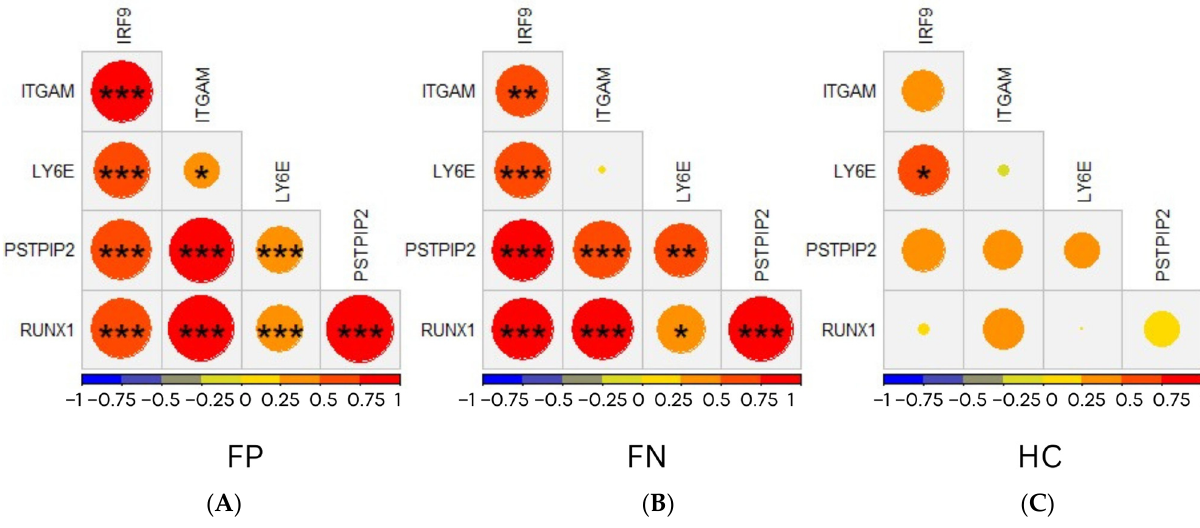
Figure 3. Correlation plots between the five genes in ( A ) FP group, ( B ) FN group, and ( C ) HC group. The size of the circle indicates the strength of the correlation, with the larger circle representing a stronger correlation. The value inside the circle represents the significance level (*** < 0.001; ** < 0.01, * < 0.05).